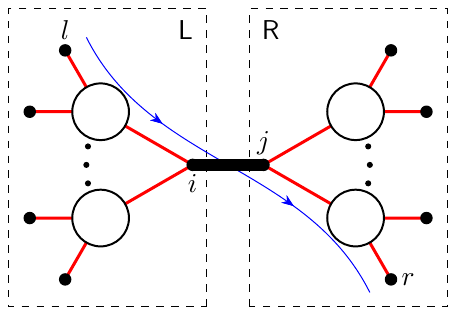
Figure 2 . The graph for general connected topology. The white blobs denote generic trees com- posed of red edges and solid